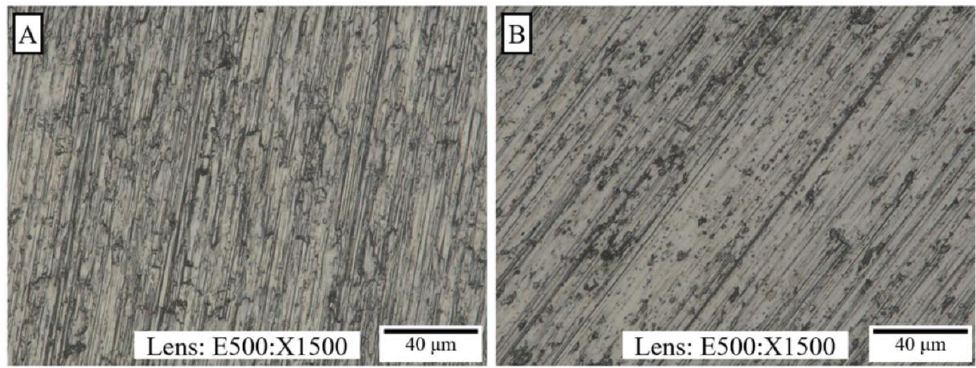
Figure 1. Structure of the VTMS coating on the Ti Gr 2 ( A ) and Ti13Nb13Zr ( B ) substrates. Photos were taken with a KEYENCE VHX digital microscope.